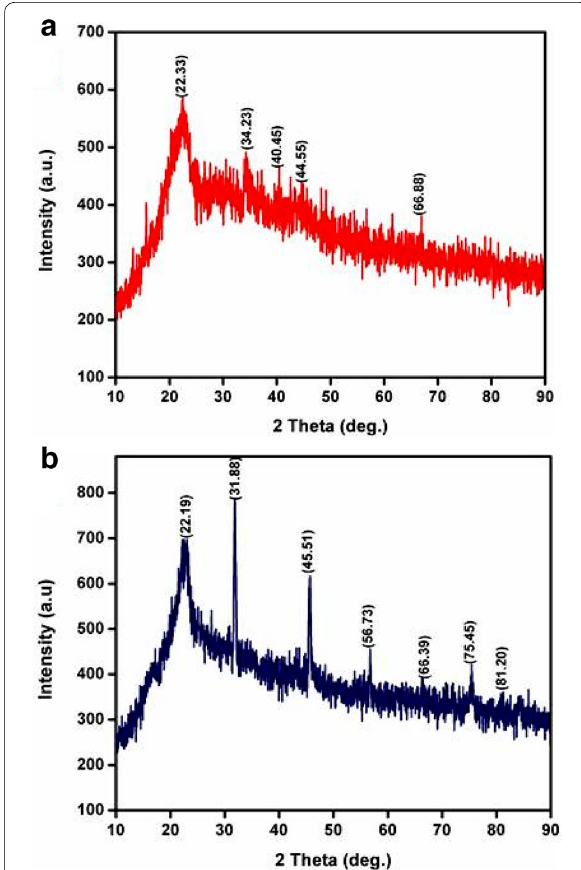
Fig. 4 XRD spectrum a raw PCB, b bioleaching residue